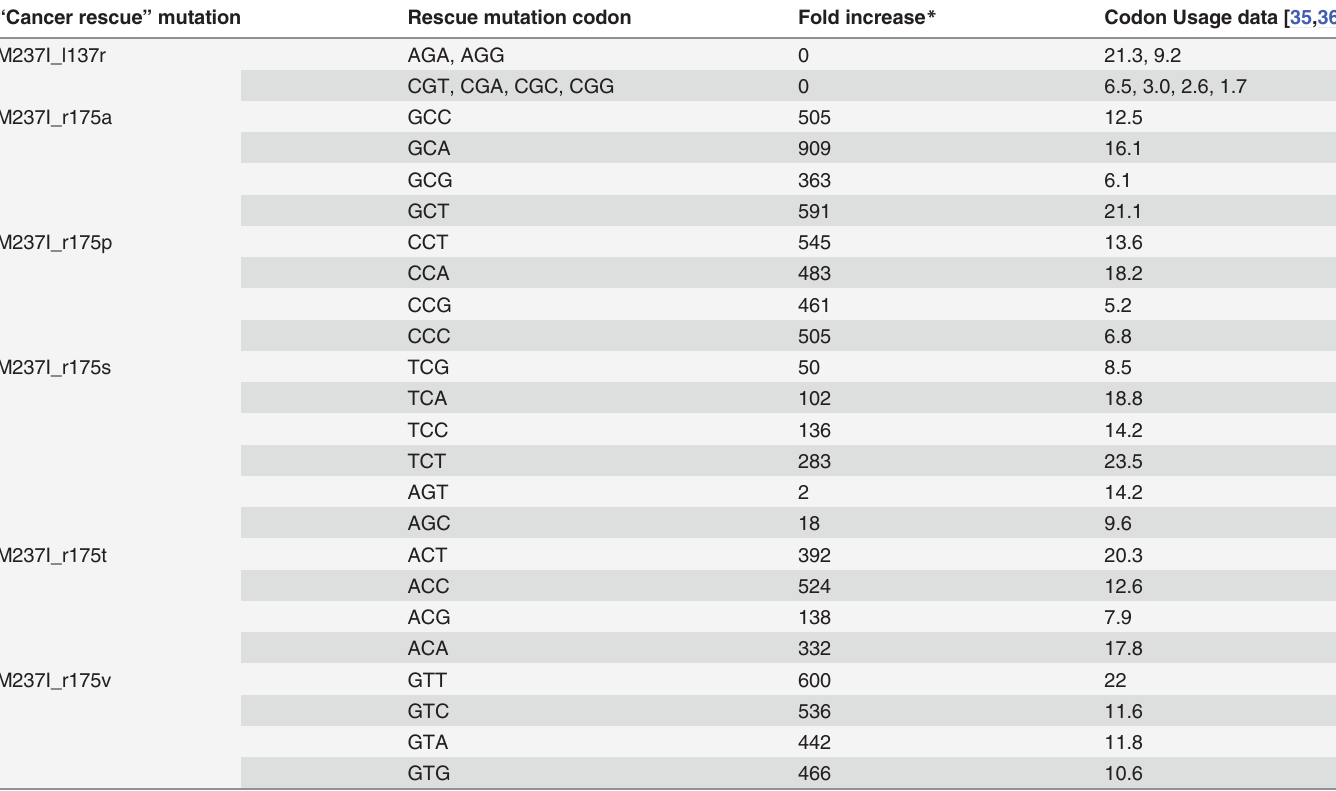
Table 2. Rescue mutations of M237I cancer mutant.